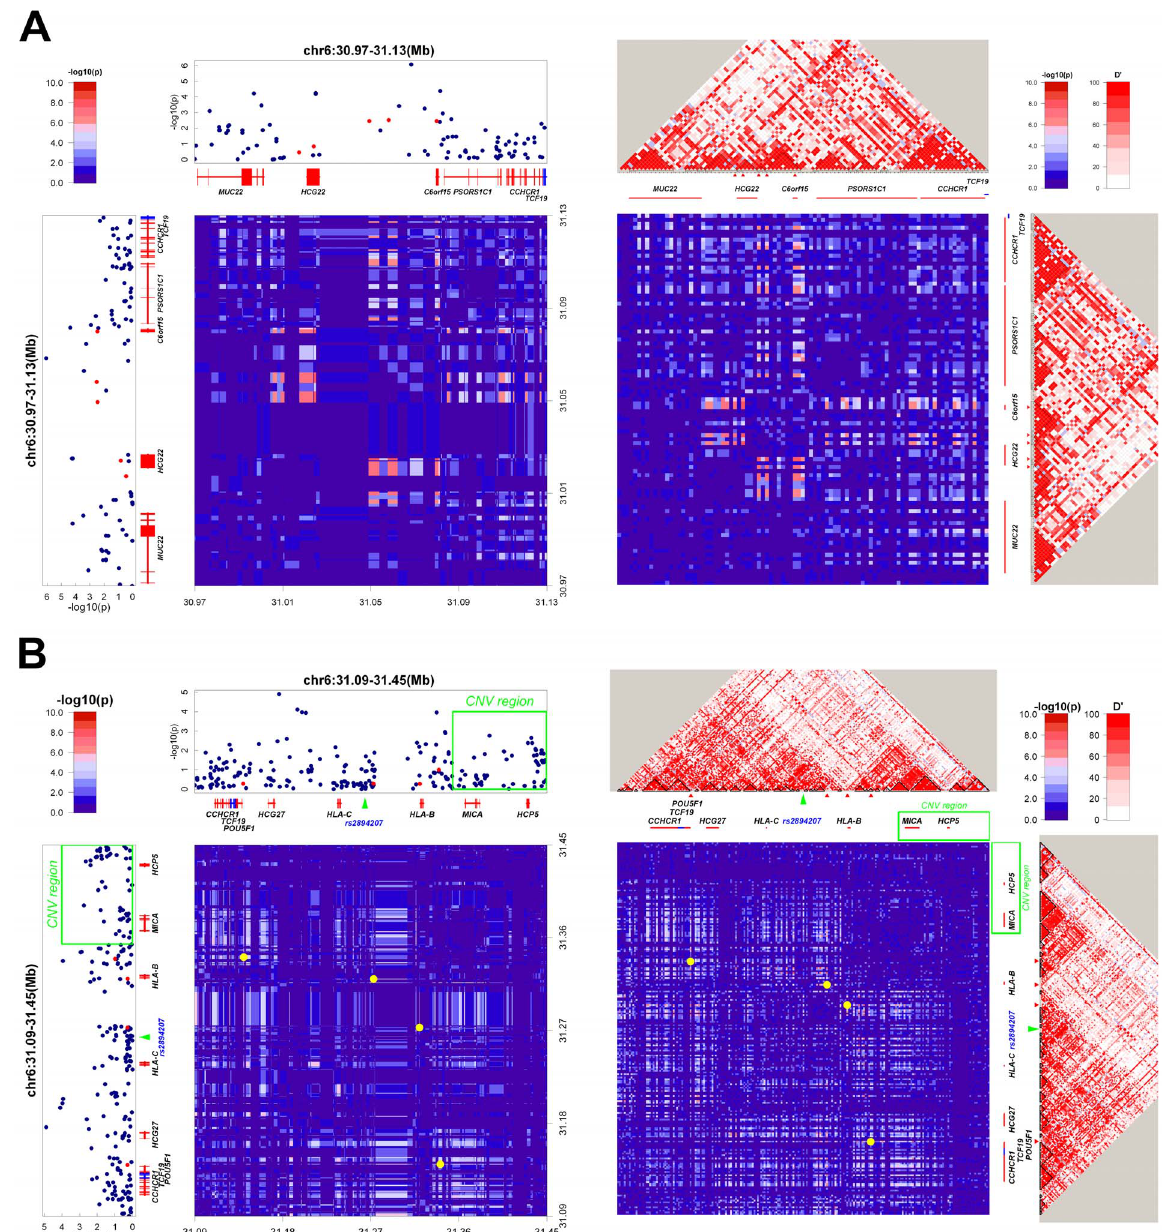
Figure 2. Regional signal plots of the interactions observed in the MHC region. The layout of this figure is similar to that described in Figure 1. Because these SNP pairs are located in a small region with a complicated interaction pattern, the same chromosome region is plotted in the 2 axes of the heatmap. On the heatmap, green arrow is position of the NPC-susceptibility SNP (rs2894207) identified by a previous GWAS study [5], green box is the copy number variations related to NPC susceptibility in men